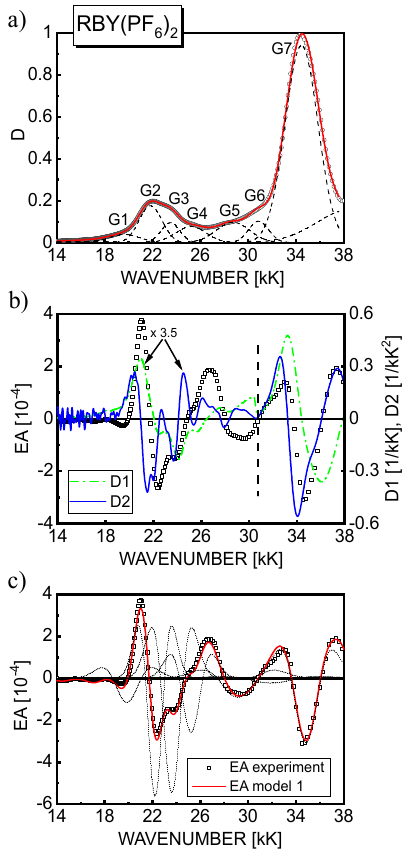
Figure 4. ( a ) The absorption spectrum of a 46 nm − thick RBY(PF 6 ) 2 (squares) and its decomposition into Gaussian bands. The solid line obtained by the superposition of the Gaussian profiles (dashed lines); ( b ) The EA spectrum of the RBY(PF 6 ) 2 film (squares) measured at an electric field strength with the rms value, F rms = 7.3 · 10 5 V/cm, compared with the calculated first (D1, dash − dotted line) and second (D2, solid line) derivatives of the absorption spectrum displayed in part (a) of the figure. The signal values of all spectra were multiplied by a factor of 3.5 in the lower − energy range indicated by the dashed vertical line; ( c ) The best fit of experimental EA spectrum of RBY(PF 6 ) 2 film (squares) with the theoretical curve calculated according to model 1 (solid line). The dotted lines represent the second derivative contributions to the EA signal from the relevant Gaussian absorption